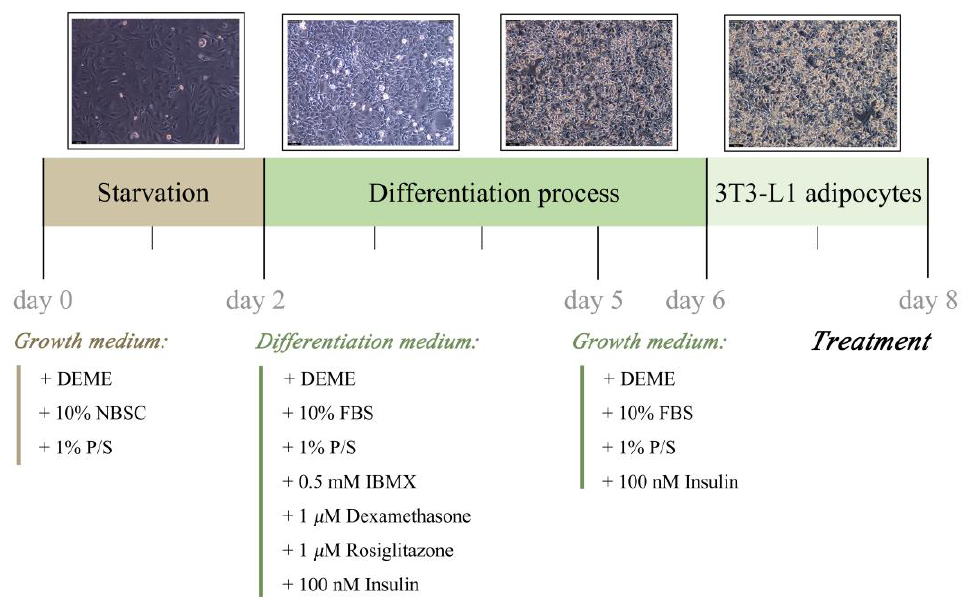
Figure 11. Differentiation process schedule. DMEM, dulbecco’s modified eagle medium; NBCS, special newborn calf serum; P/S, penicillin/streptomycin; FBS, certified fetal bovine serum; IBMX, 3-isobutyl-1-methyl-xanthine.